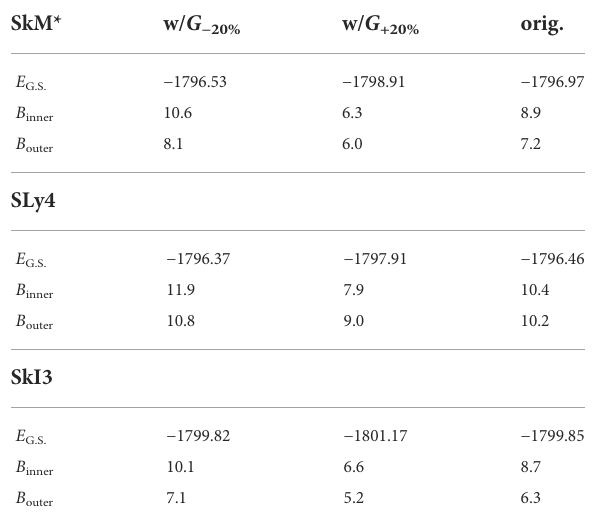
con fi guration dependence of the effect of the pairing correlation. The barrier heights and E (G.S.) for each interaction are shown in Table 2. In all the cases investigated, it is concluded that